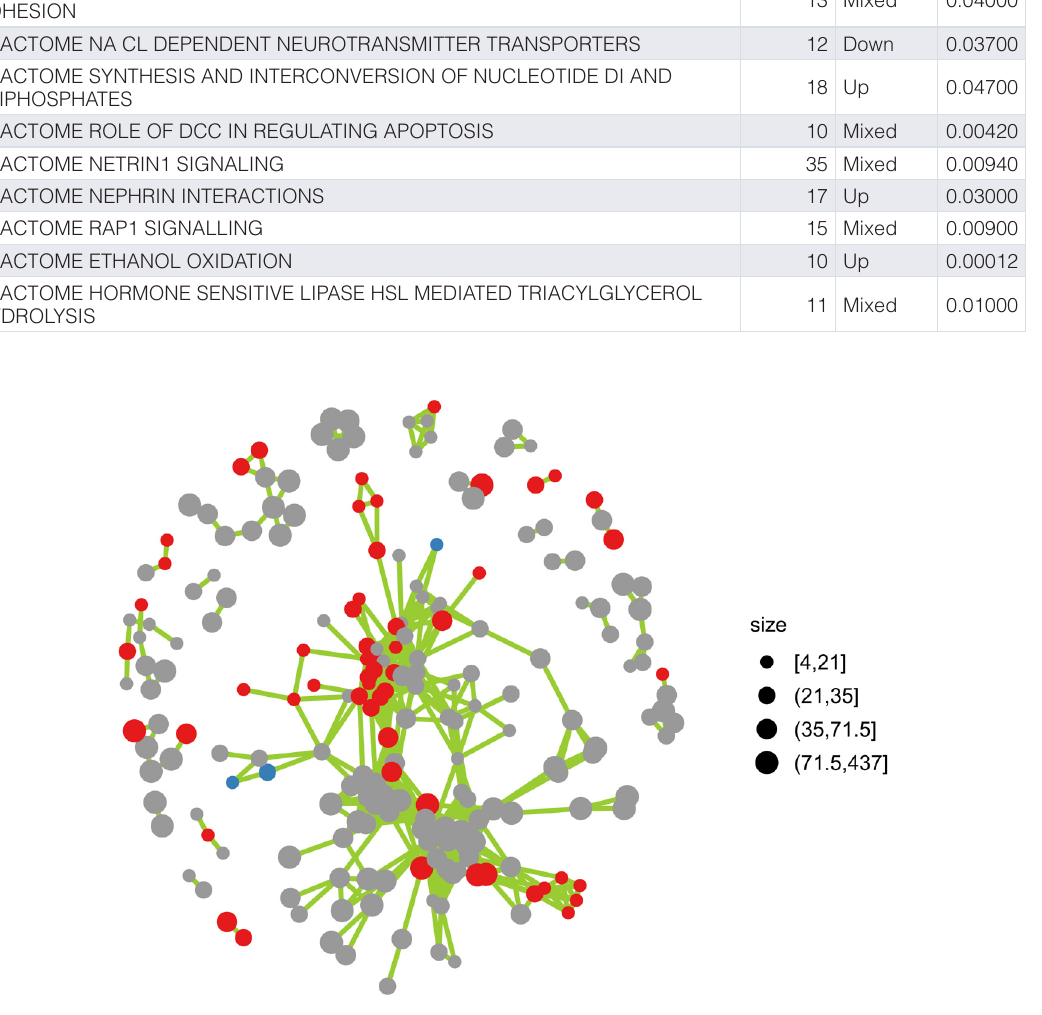
Figure 2. Gene set network with singletons removed. The color scheme is the same as above. The node size corresponds to the number of genes in a